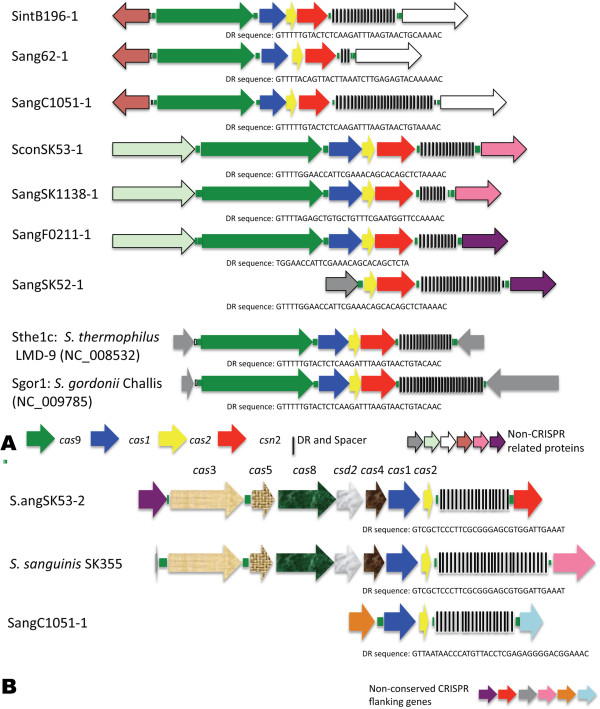
Comparative analysis of the Type II-A (Nmeni) SAG CRISPR. A) Schematic view of the Type II-A CRISPR regions identified within SAG. B) Schematic view of the Type I-C CRISPR region identified within SA. Similar colored arrows indicate gene loci conserved between SAG. The number of DR and spacer regions are indicated by black bars, with the number of bars correlating to number of regions present within each CRISPR.